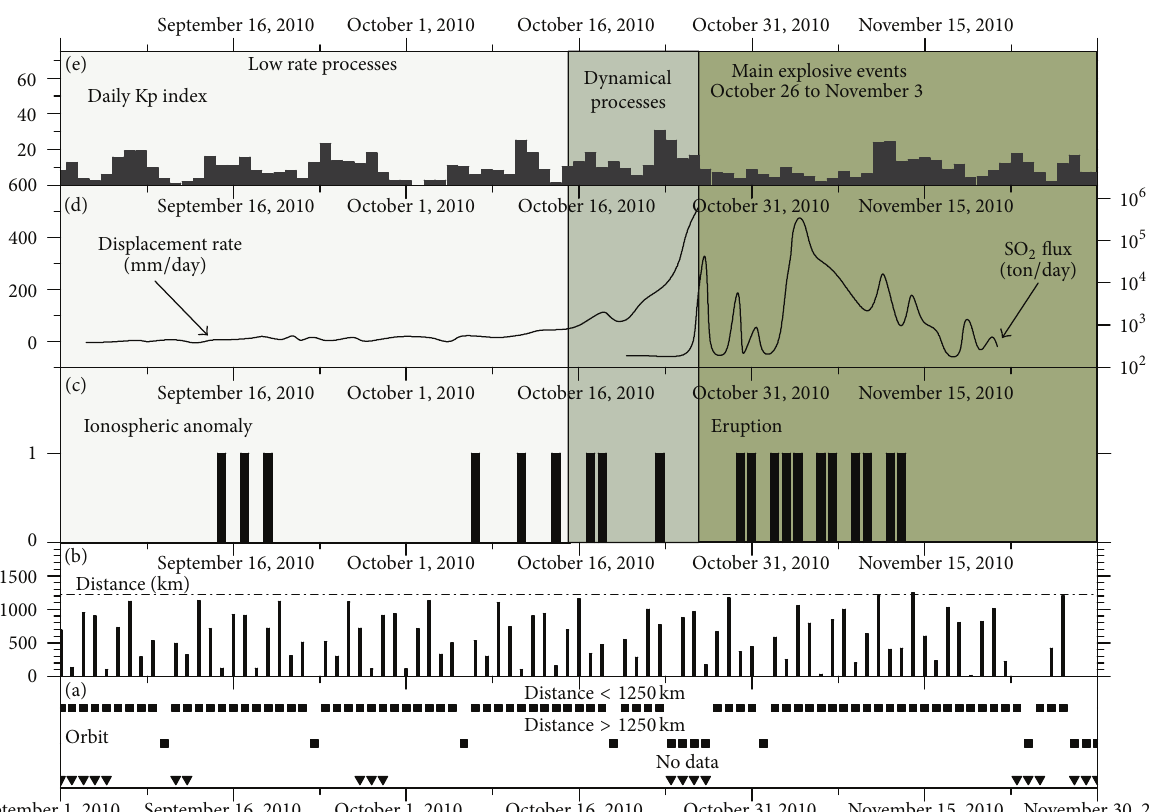
Figure 8: Ionospheric anomalies recorded during the period from September 1 to November 30, 2010, and related to the October 26 eruption of Merapi volcano. (a) Available nighttime DEMETER orbits and distance between the satellite footprint and the volcano; no data available are drawn with downwards black triangles. (b) Distance between the satellite and the volcano. (c) Recognised ionospheric anomalies. (d) Daily displacement rate on the southern flank of the volcano and SO 2 flux discharge (following Surono et al., 2012). (e) Daily Kp index and synthetic activity. Light grey rectangle corresponds to the end of the mechanical fatigue period, medium grey rectangle fits to the dynamical processes period, and dark grey rectangle matches with the beginning of the surface